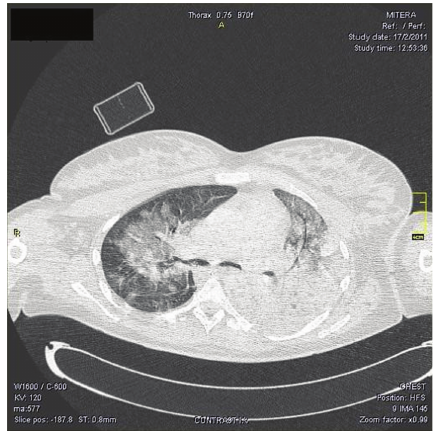
Figure 3: Chest CT confirming bilateral basilar pulmonary consol- idation, consistent with pneumonic